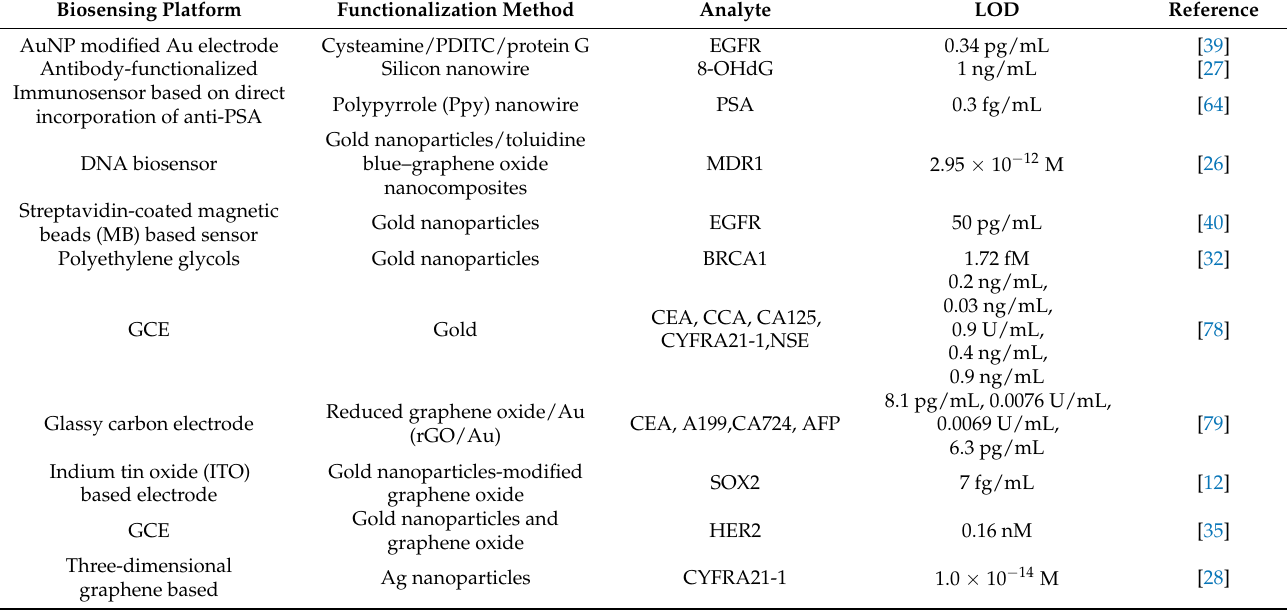
Table 1. Electrochemical biosensing platforms to detect cancer biomarkers.